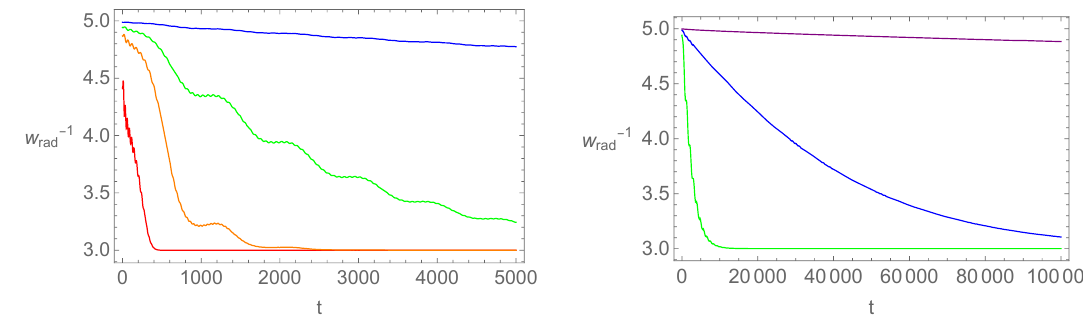
for various values of σ . The parameter is chosen from the Figure 12. Time evolution of w − 1 ∗ rad bottom to the top as σ = 4 . 6 (red), 6.0 (orange), 6.8 (green), 8.3 (blue), which correspond to ∗ b vac = 5 . 0 , 10.0, 15.0, 31.7 in the left plot, and σ ∗ = 6 . 8 (green), 8.3 (blue), 10.6 (purple), which correspond to b = 15 . 0 , 31.7, 100 in the right plot. The other parameters are chosen as vac